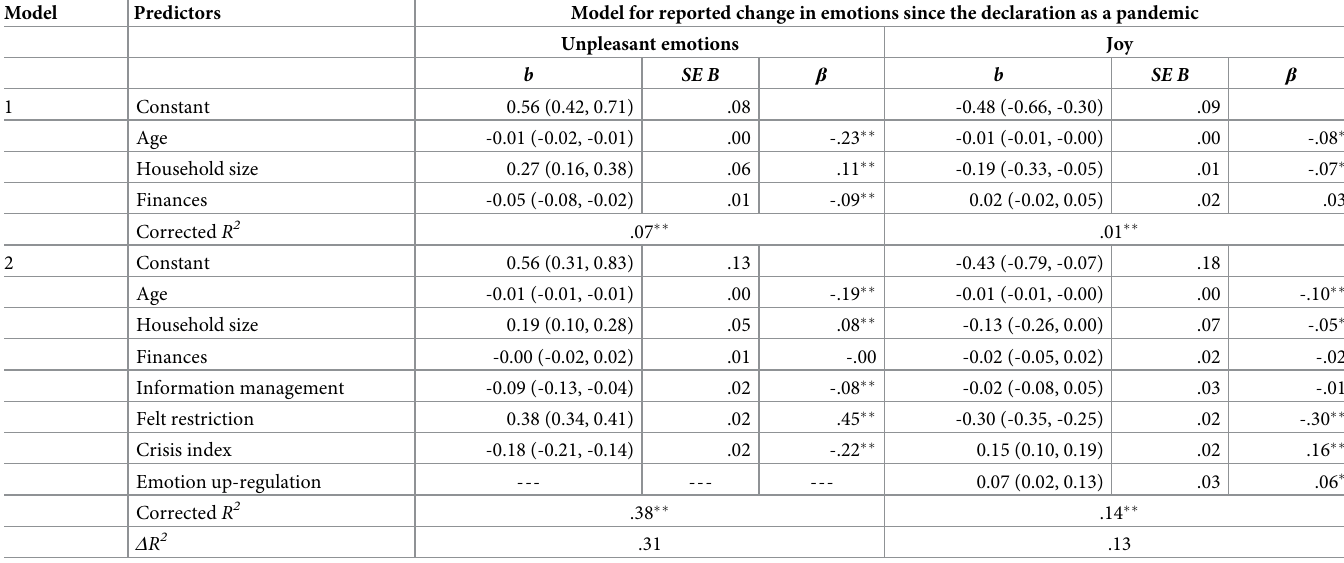
Table 3. Linear model of predictors of change in unpleasant emotions and joy.